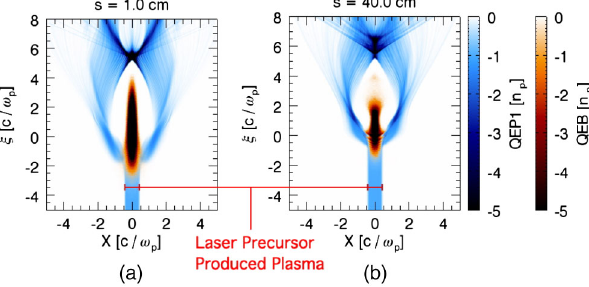
FIG. 7. Density snapshots of the plasma wake with a small preformed Li plasma column. The plasma electron density has the blue color and the beam density is in